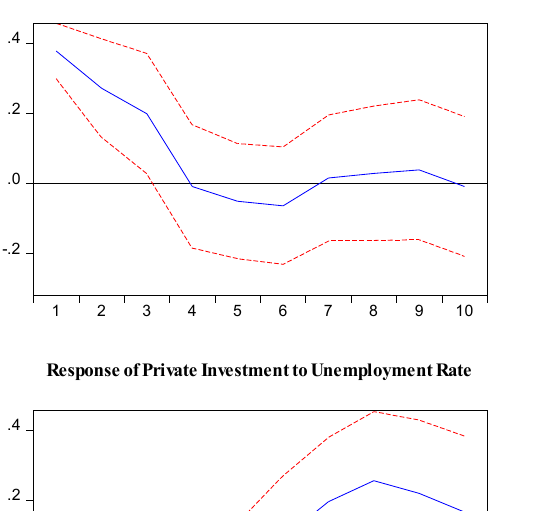
Figure 6: Response of Private Investment to Military Spending and Other Variables